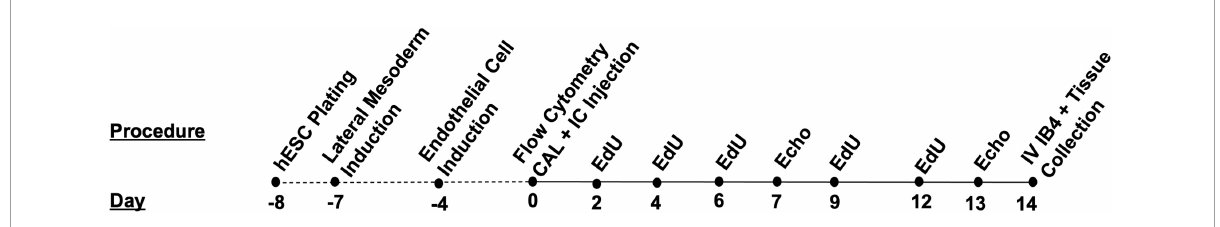
FIGURE1 Timeline and design of human embryonic stem cell-derived endothelial cell product (hESC-ECP) differentiation and the 14-day study.